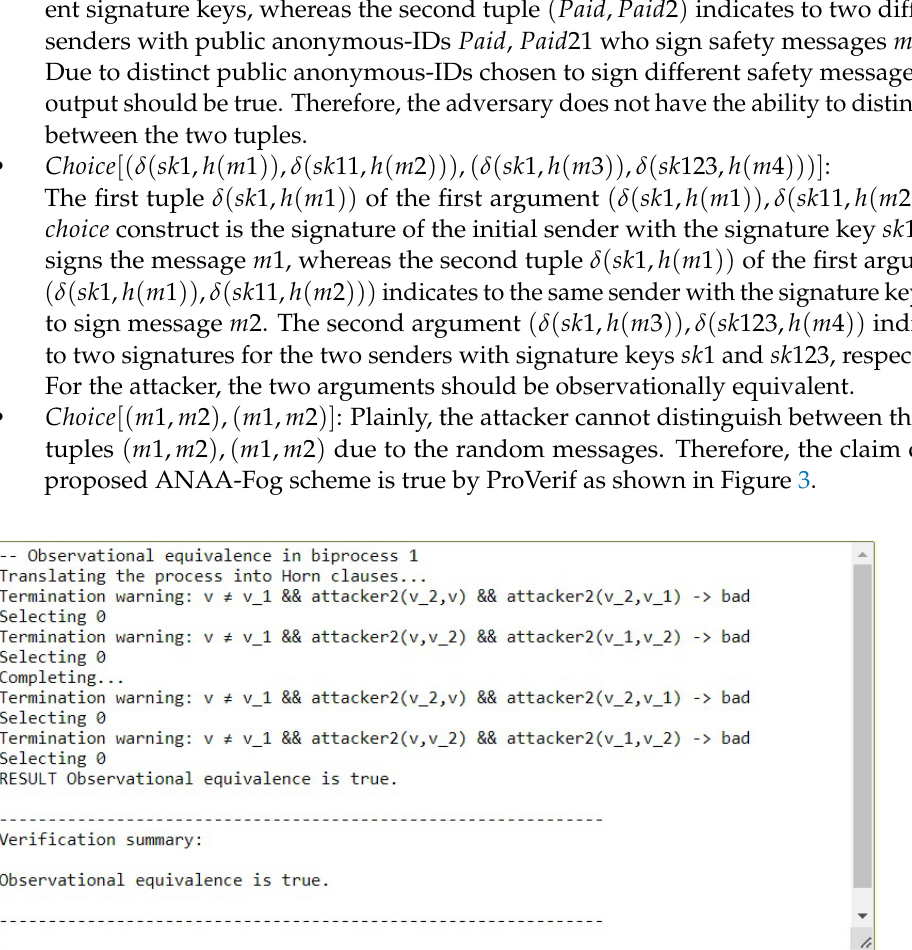
Figure 3. The Output of ProVerif on